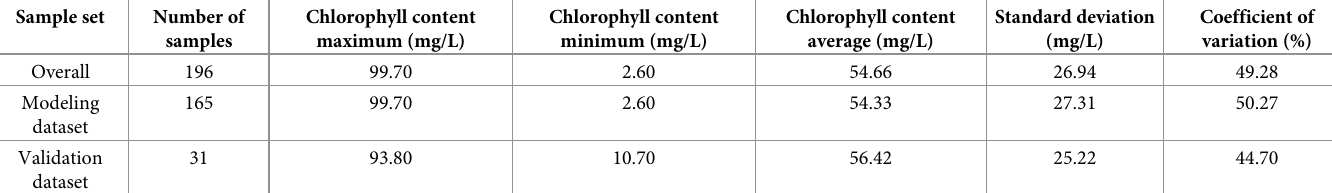
Table 1. Statistical characteristics of chlorophyll content in japonica rice in test plots.